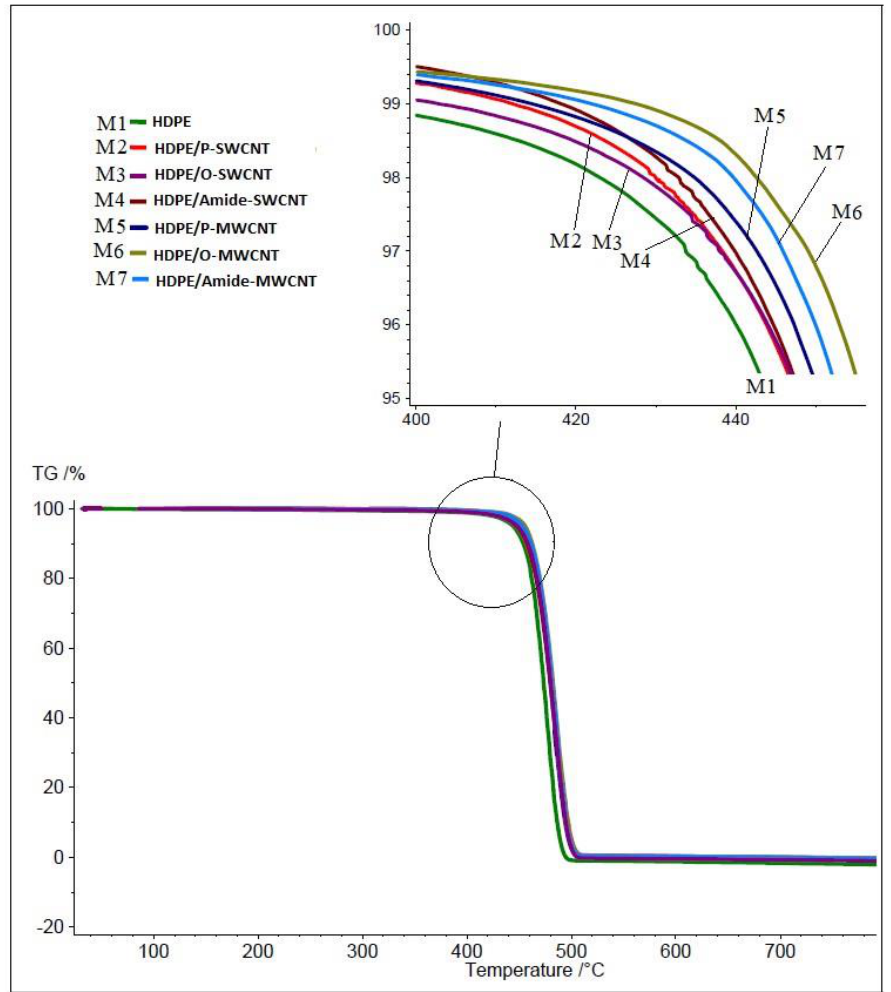
Figure 3. TGA degradation graphs for the nanocomposite sheets M1–M7 performed with heating rate of 10 °C/min from 25 °C to 800 °C in nitrogen atmosphere.